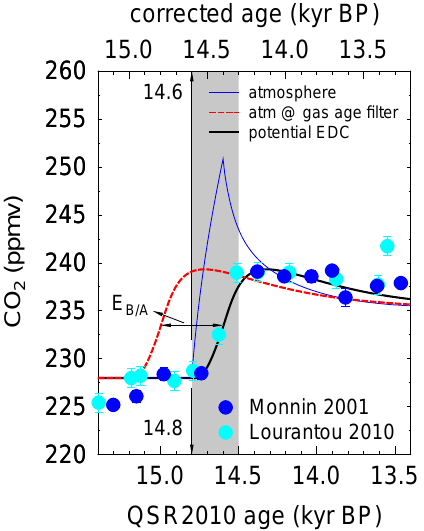
Fig. 7. Influence of the gas age distribution PDF on the CO 2 signal. The original atmospheric signal (blue) leads to a time series (red) with similar characteristics (e.g., mean values) after filtering with the gas age distribution PDF with the width E B / A = 400yr. To ac- count for the use of the width of the gas age PDF in the gas chronol- ogy (R. Spahni, personal communication, 2010) the resulting curve has to be shifted by E B / A towards younger ages to a time series potentially recorded in EDC (black). This leads to a synchronous start in the CO 2 rise in the atmosphere (blue) and in EDC (black) around 14.8kyr BP on the ice core age scale QSR2010 (lower x- axis) (Lemieux-Dudon et al., 2010). Due to a similar gas age dis- tribution PDF of CH 4 the synchronisation of ice core data contains a dating artefact which is for EDC at the onset of the B/A around 200yr (Appendix B, Supplement). On the age scale corrected for the synchronisation artefact (upper x -axis), the onset in atmospheric CO 2 falls together with the earliest timing of MWP-1A (grey band) (Hanebuth et al., 2000; Kienast et al., 2003).